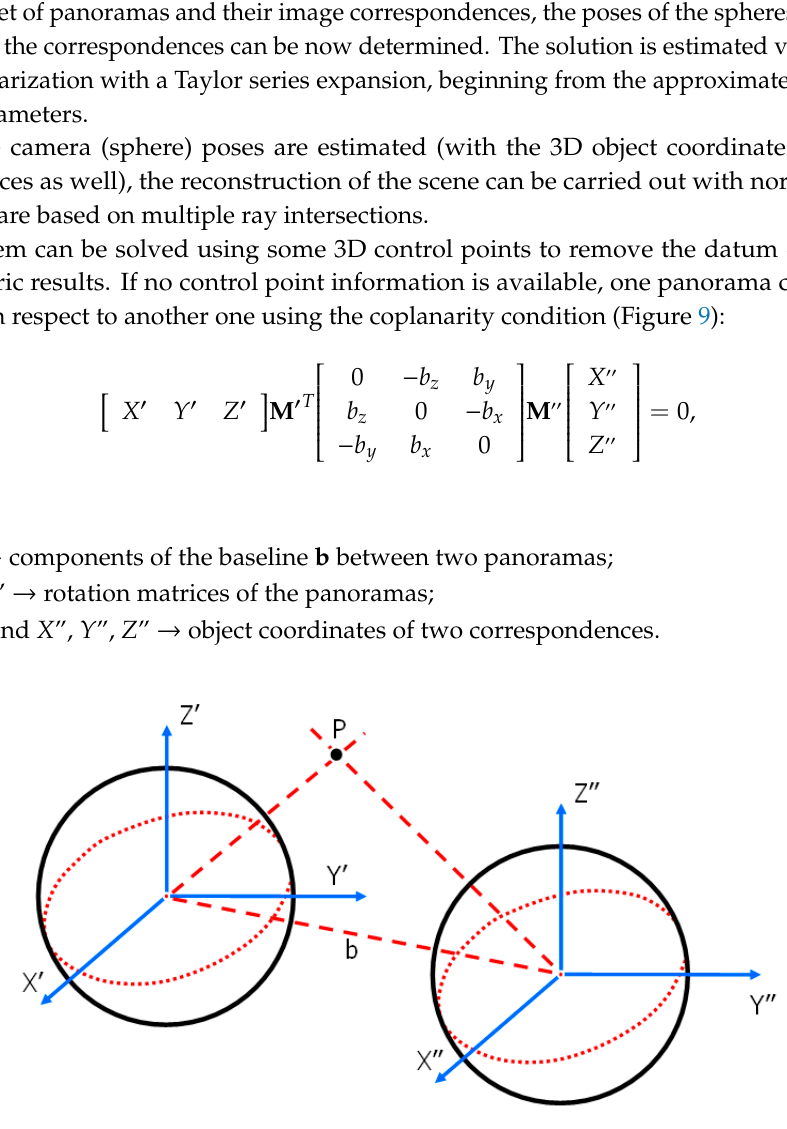
Figure 9. The coplanarity condition between two spherical panoramas.